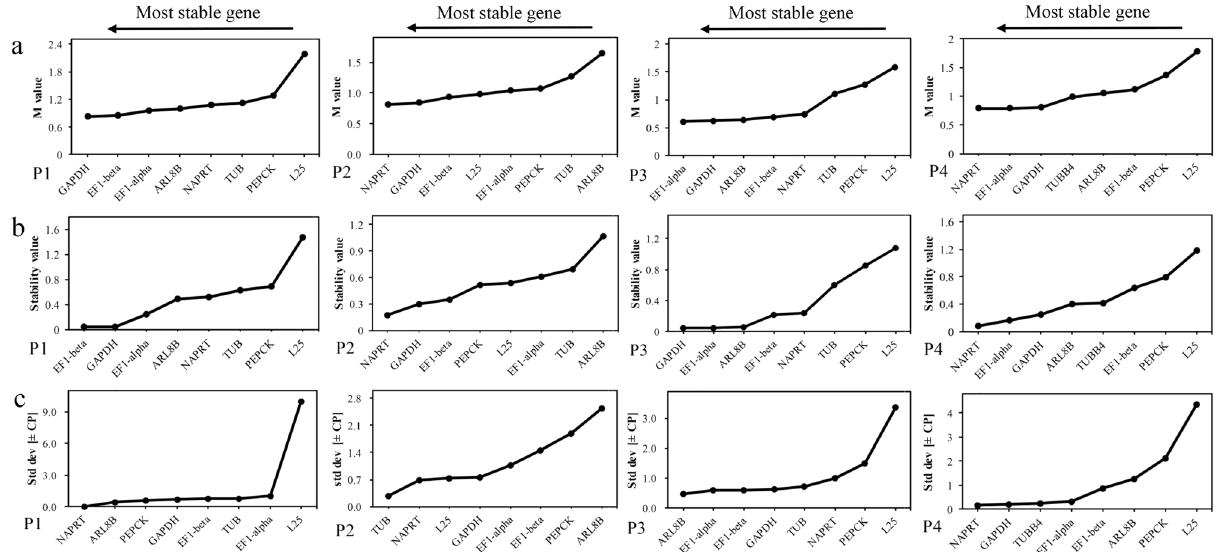
Figure 4. Expression stability of eight candidate reference genes in Dp of P. ternata as calculated by geNorm ( a ), NormFinder ( b ) and Bestkeeper ( c ) . P1 = Period 1; P2 = Period 2; P3 = Period 3; P4 = Period